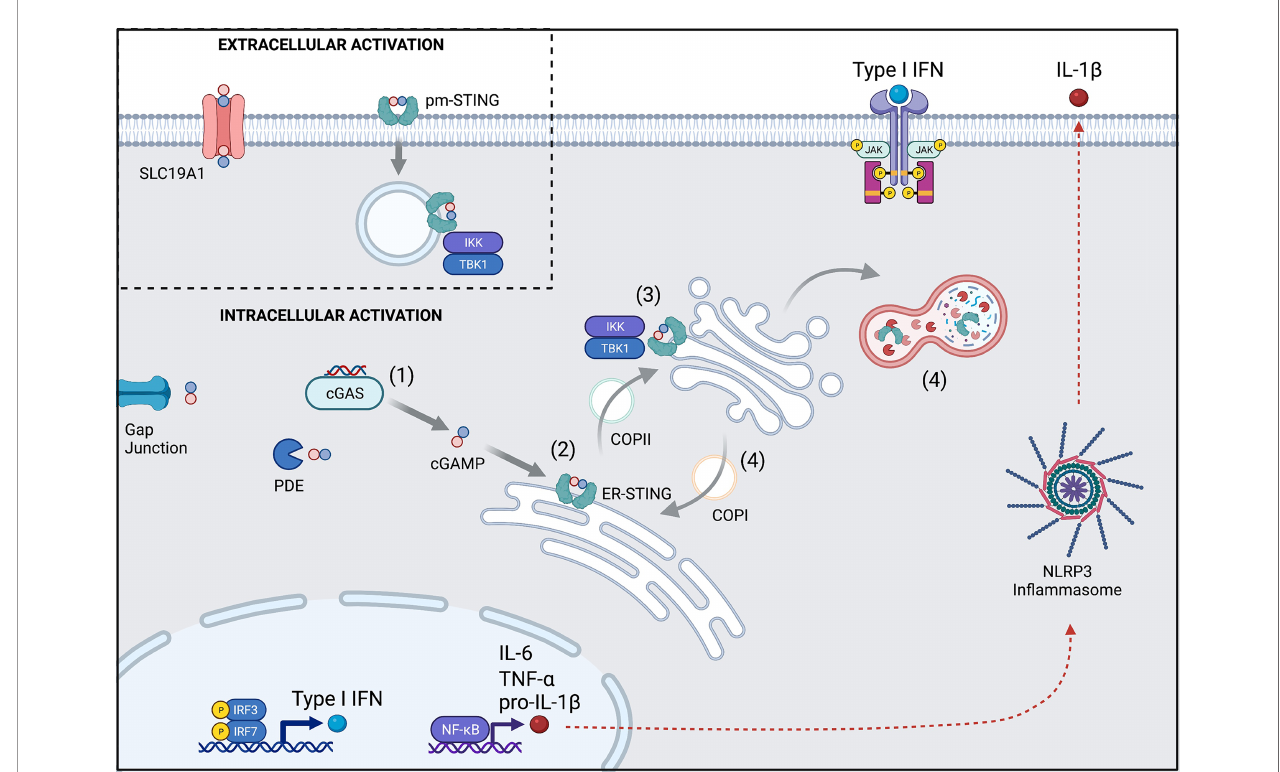
FIGURE 1 | Overview of the cGAS-STING pathway and its regulation. (1) cGAS is activated upon binding to dsDNA to synthesize cGAMP from ATP and GTP. Some cGAMP is lost to intercellular spread via gap junctions or degradation by phosphodiesterases (PDE), but the remainder can bind to STING. (2) cGAMP-bound STING traf fi cks from the ER to the Golgi apparatus through COPII and becomes activated en route . (3) Activated STING recruits TBK1 and IKK to upregulate transcription of Type I interferons and NF- k B. (4) STING signaling is terminated when it is either degraded in the autolysosome or recycled back to the ER via COPI. (Inset) Extracellular cGAMP can trigger STING activation after import by the SLC19A1 transporter or by direct binding to pm-STING. Numbers also refer to stages described in text. pm, plasma membrane; ER, endoplasmic reticulum. Created with